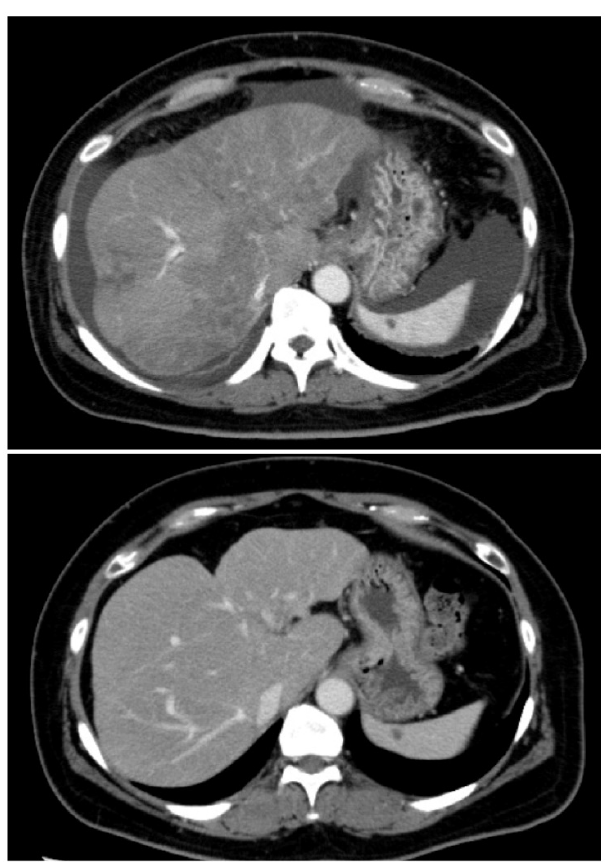
Figure 3. Computed tomography performed before ( above ) and after ( below ) alectinib therapy. Liver lesion and ascites disappeared after alectinib therapy.